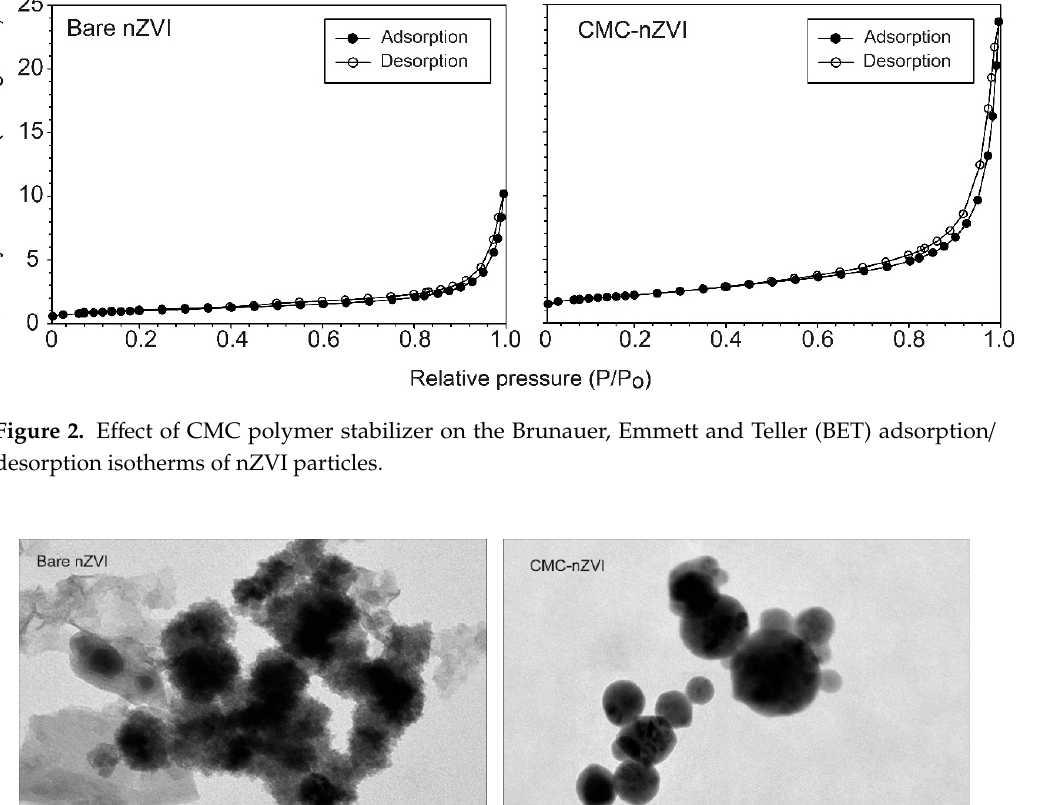
Figure 3. Transmission electron microscope (TEM) images of bare and CMC–nZVI particles.